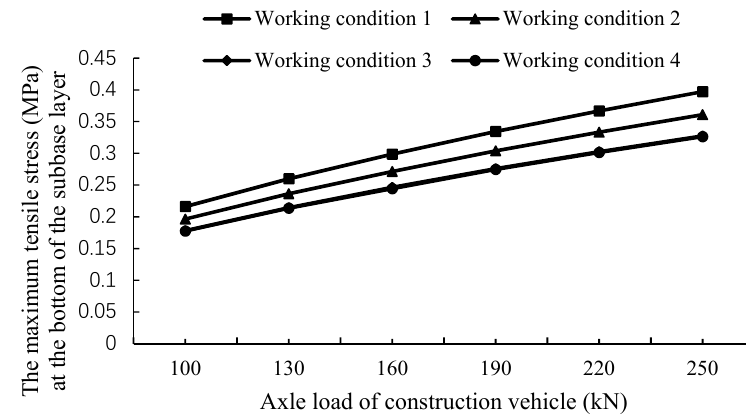
Figure 13. Maximum tensile stress under different working conditions.